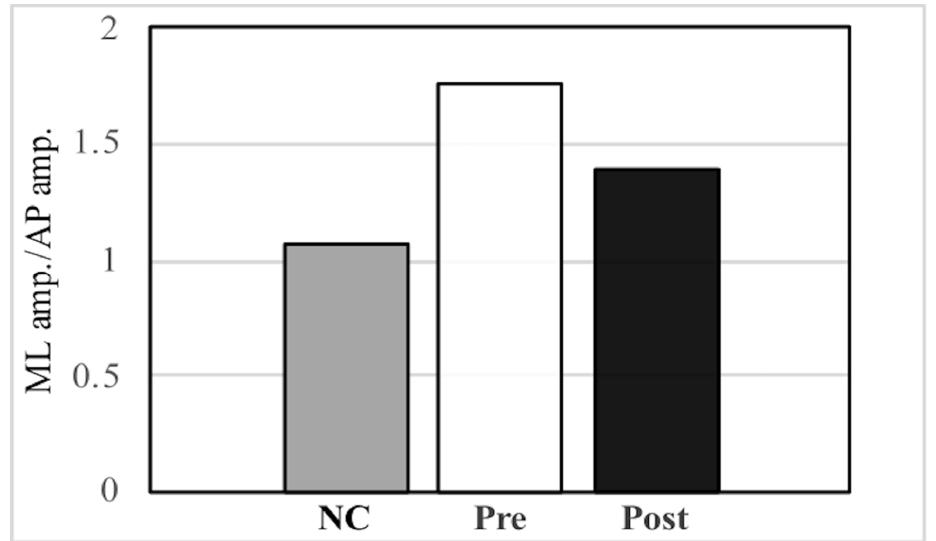
Figure 6. Comparison of the mediolateral (ML) amplitude/vertical (VT) amplitude ratio and ML amplitude/anteroposterior (AP) amplitude ratio between normal controls (NC) and pre- and post- music therapy individuals with Parkinson’s disease.